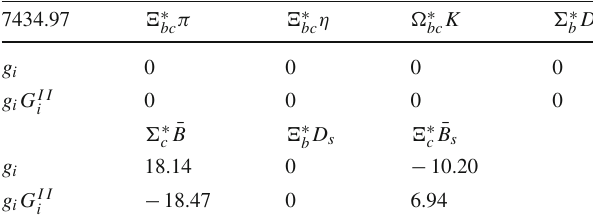
Table 34 Coupling constants to various channels and g i G II with q max = 650MeV 7434.97